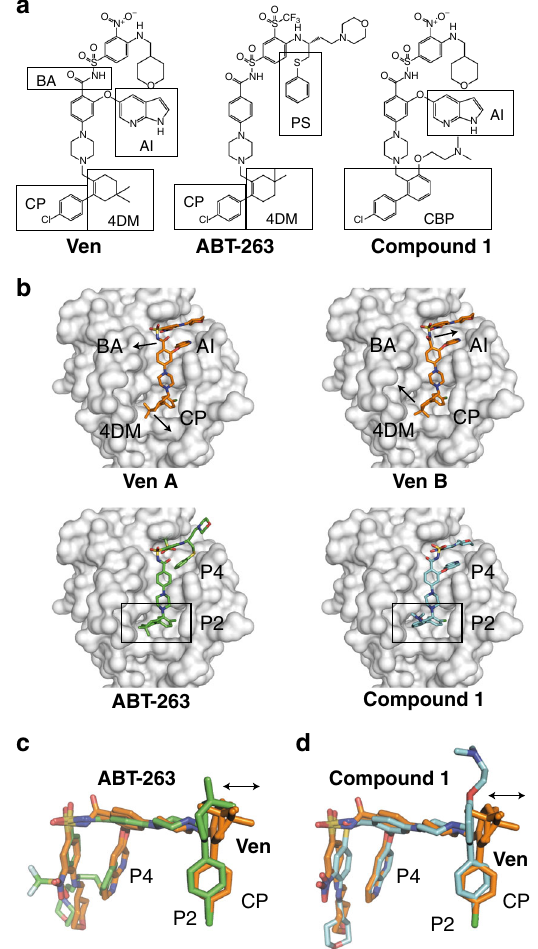
Fig. 1 Venetoclax binding to BCL-2. a Chemical structures of venetoclax (Ven) and related compounds ABT-263 and compound 1 . Key features are marked, including the benzamide (BA), the 4-chlorophenyl (CP), the partially saturated 4 – 4-dimethylcyclohex-1-ene (4DM), the 5 – 5- dimethylcyclohex-1-ene (5DM), the saturated 4 ′ -chlorobiphenyl (BP), the azaindole (AI) and phenyl sulfonyl (PS). b Crystal structures showing binding of the two venetoclax conformers (Ven A and Ven B, orange), and comparison to ABT-263 (green, PDB id 4LVT) and compound 1 (cyan, PDB id 4MAN) binding to the BCL-2 groove. BCL-2 is shown with surface representation (white) and P2 and P4 pockets indicated along with arrows depicting changes between venetoclax alternate conformations for BA and 4DM moieties. c , d overlays of venetoclax with ABT-263 ( c ) and compound 1 ( d ) with arrows indicating deviations compared to the venetoclax